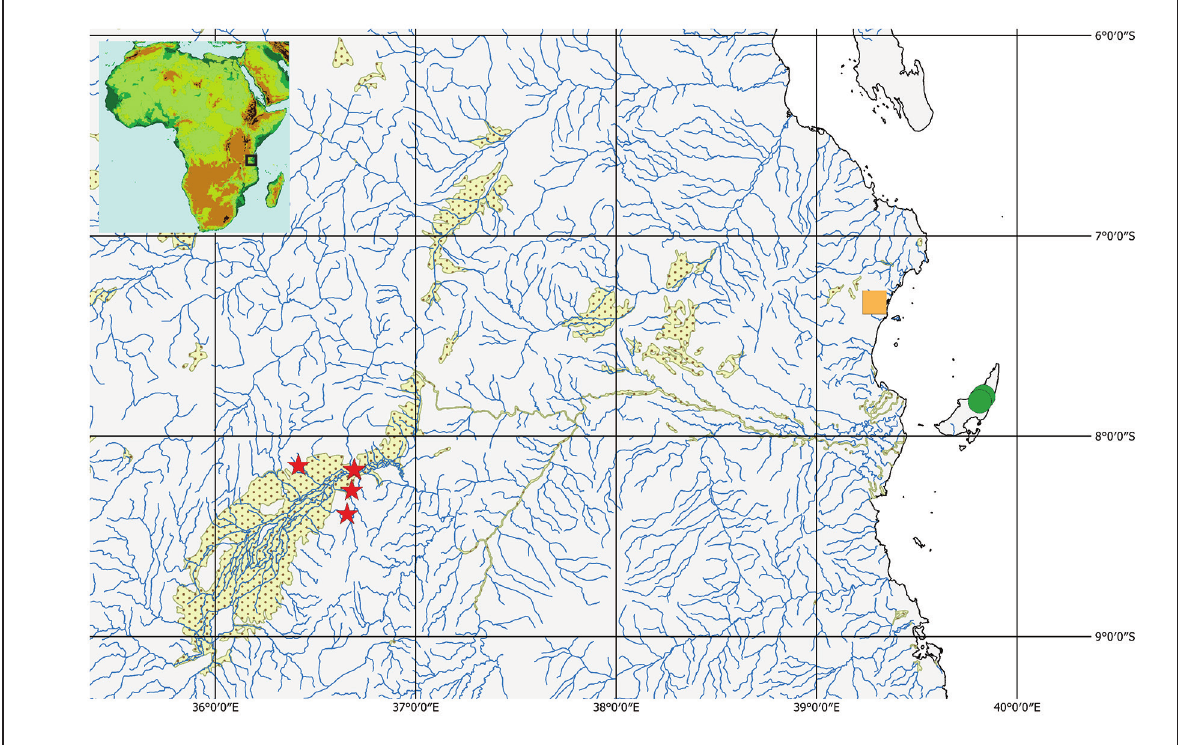
Figure 2. Geographical distribution of Nothobranchius lucius (stars), Nothobranchius cf. lucius (square), and Nothobranchius insularis sp. n. (circles); dotted areas are Table 1. Morphometric data of Nothobranchius lucius .